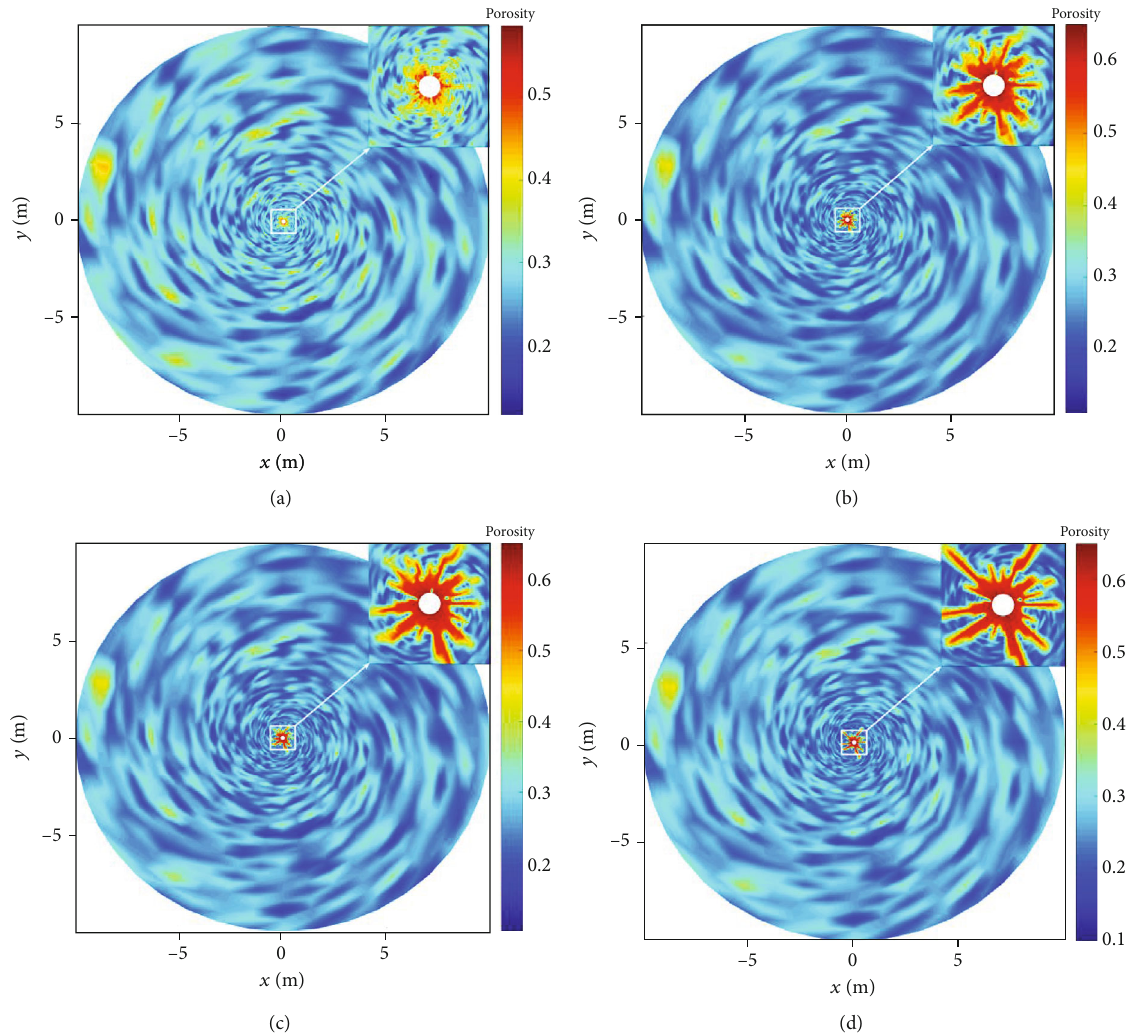
Figure 3: Porosity distribution near the injection well at di ff erent injection times. (a) t = 1000 s . (b) t = 5000s . (c) t = 10000s . (d) t = 20000 s .